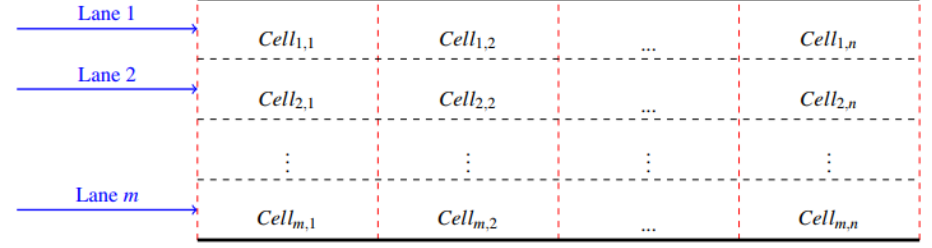
Figure 1. Cells structure of a road